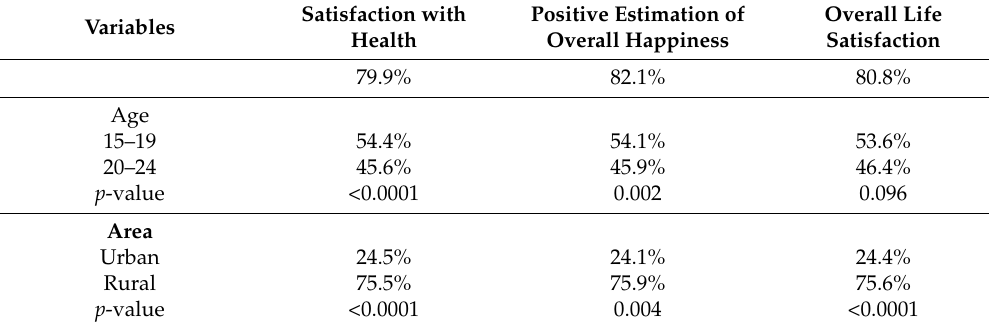
Table 2. Percentage of women who reported being satisfied with health, overall happiness, and life across the explanatory variables, Nepal MICS